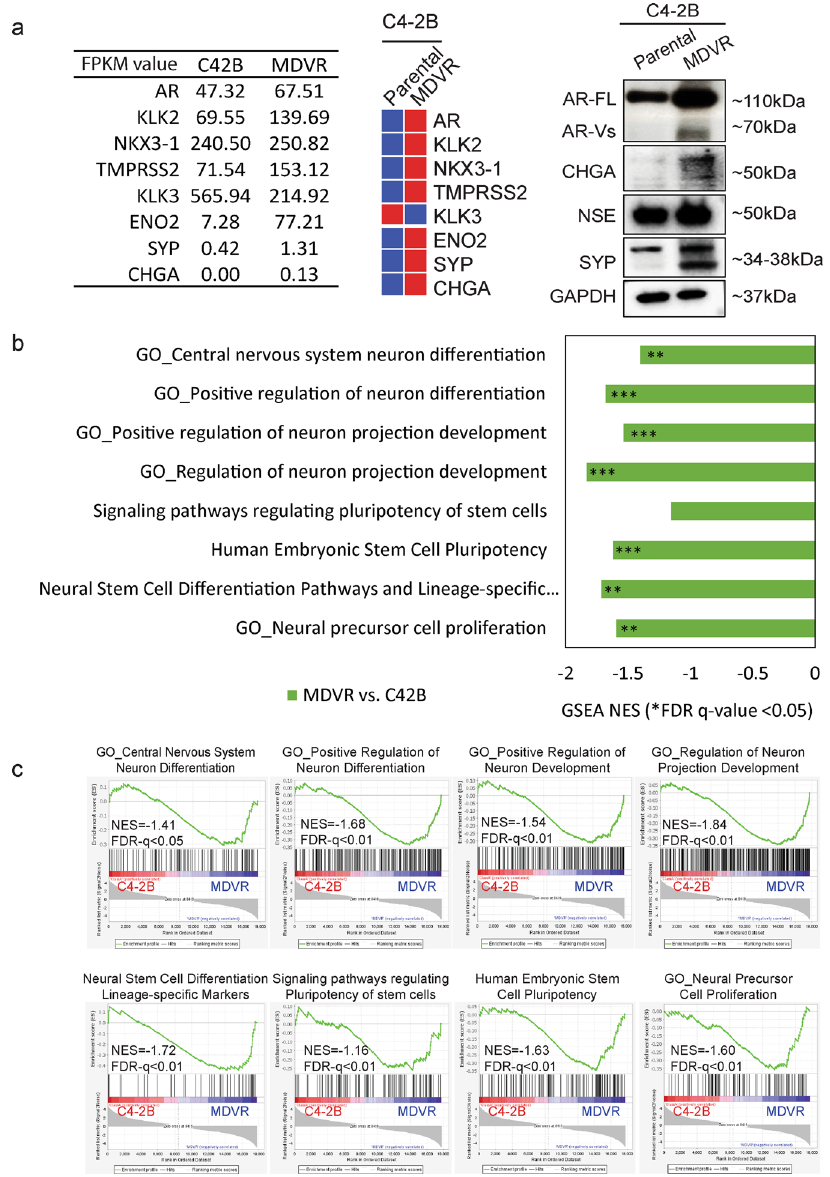
Fig. 1 Neural lineage pathways enriched in enzalutamide-resistant prostate cancer C4-2B MDVR cells. a Gene and protein expression of the classical NE markers in C4-2B MDVR cells compared to the parental C4-2B cells. b Summarized GSEA analysis of enriched pathway or gene sets in C4-2B MDVR cells compared to the parental cells. The altered gene sets from Gene Ontology and PathCards were generated by GSEA software. c Enrichment plots of GSEA analyses for the neural lineage pathways in C4-2B MDVR cells compared with C4-2B parental cells. NES, showing normalized enrichment score (NES) and corresponding signi fi cance for the eight pathways. *FDR q value <0.05, **FDR q value <0.01, ***FDR q value <0.001. NE neuroendocrine, GSEA Gene Set Enrichment Analysis, FDR false discovery